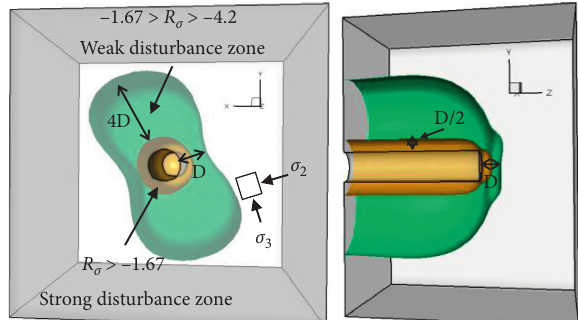
Figure 9: Nephogram of stress triaxiality as the tunnel face approaches the reference